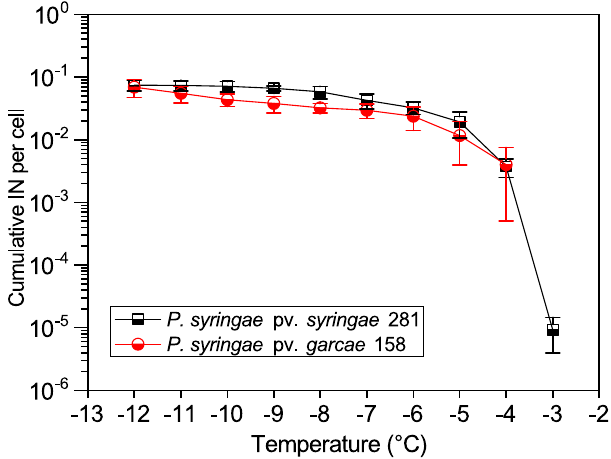
Figure 1. Ice nucleation spectrum of the P. syringae strains. Cultures of P. syringae pv. syringae 281 and P. syringae pv. garcae 158 grown in L NP medium at 15 °C were tested with the droplet freezing assay to quantify their ice nuclei (IN) concentration at decreasing temperatures. The data points at warmer temperatures represent the initial temperature at which frozen droplets could be detected for each strain. Error bars denote standard deviations of the means (n =